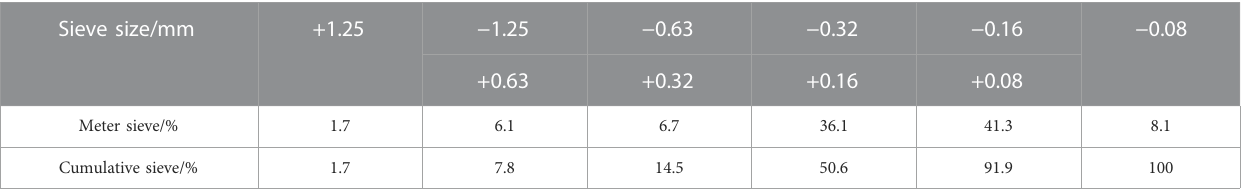
TABLE 2 Particle size distribution of